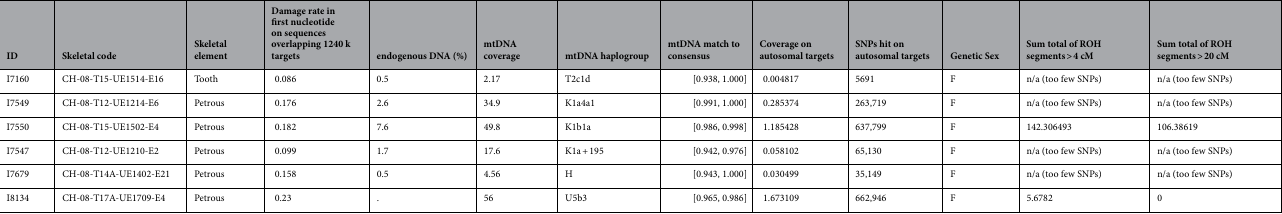
Table 5. Summary of genetic results.